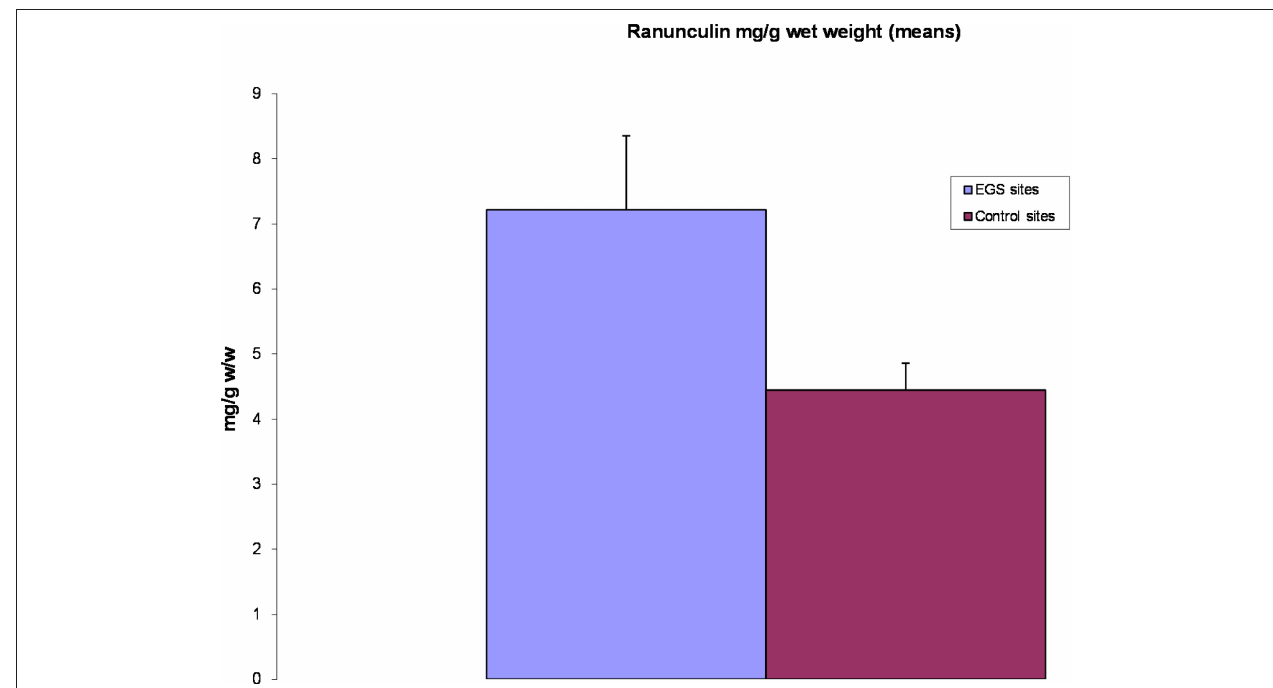
FIGURE 6 | Ranunculin levels (means). Chart showing means of ranunculin content from EGS site Ranunculus samples compared to controls. Note that ranunculin is significantly higher ( p < 0.05) in EGS site